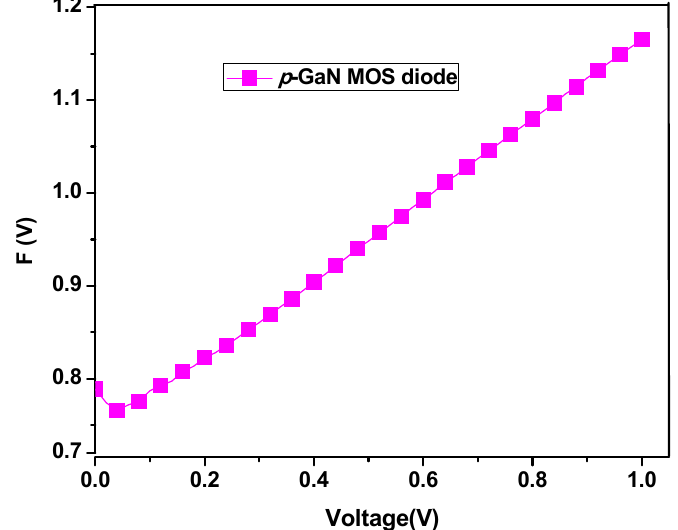
Figure 5. Characterization of the F( V , I ) vs. V for the as-deposited Al/SiO 2 / p- GaN MOS Schottky diode.